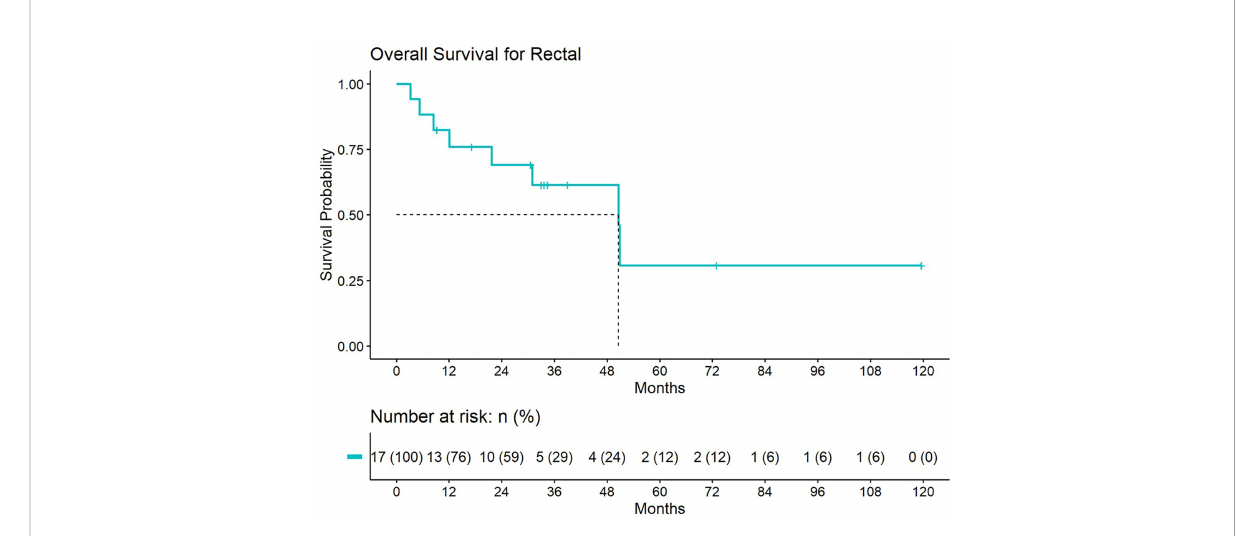
FIGURE 6 Overall survival for patients treated with a second course of pelvic radiation for de novo rectal cancers after prior prostate